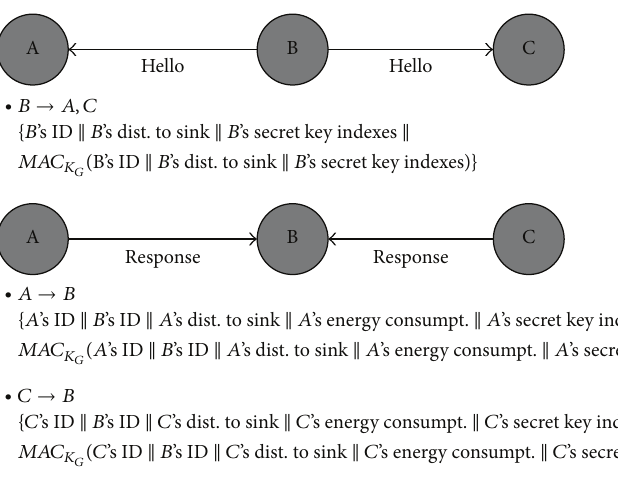
Figure 4: Neighbor discovery process using Hello and Response